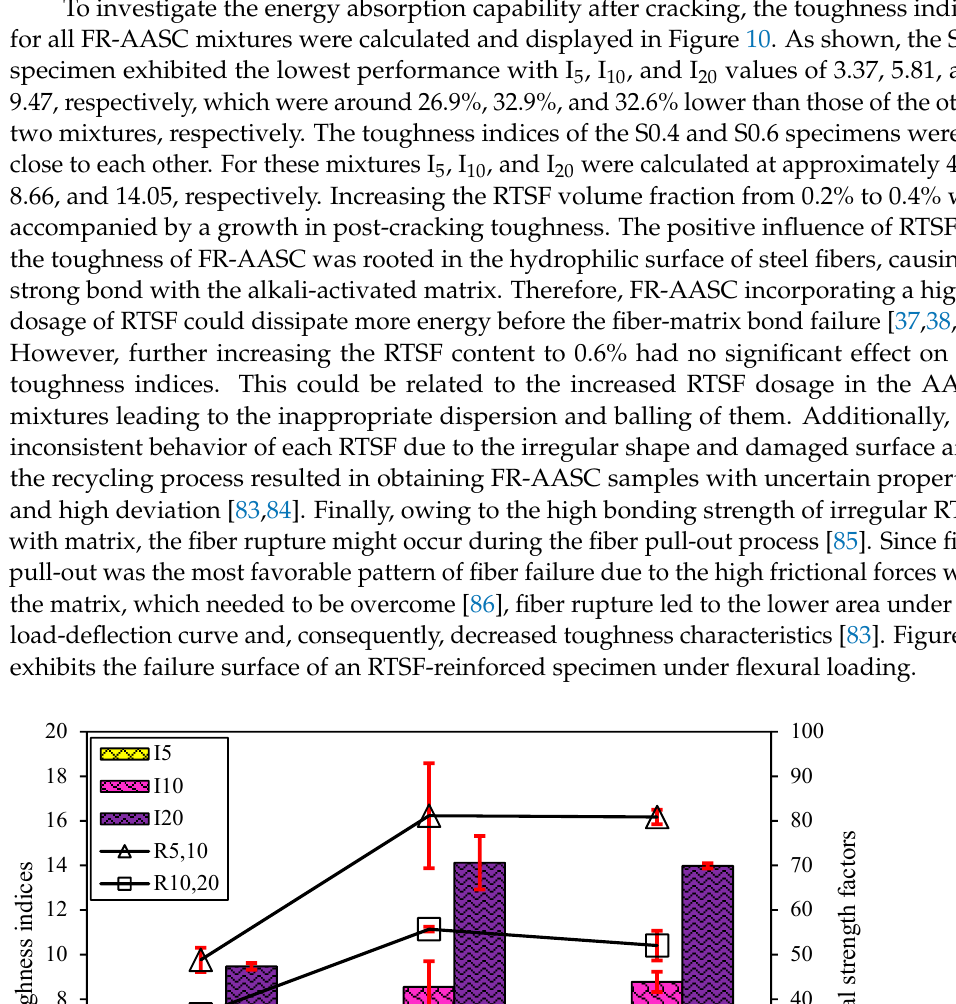
slightly higher than those of